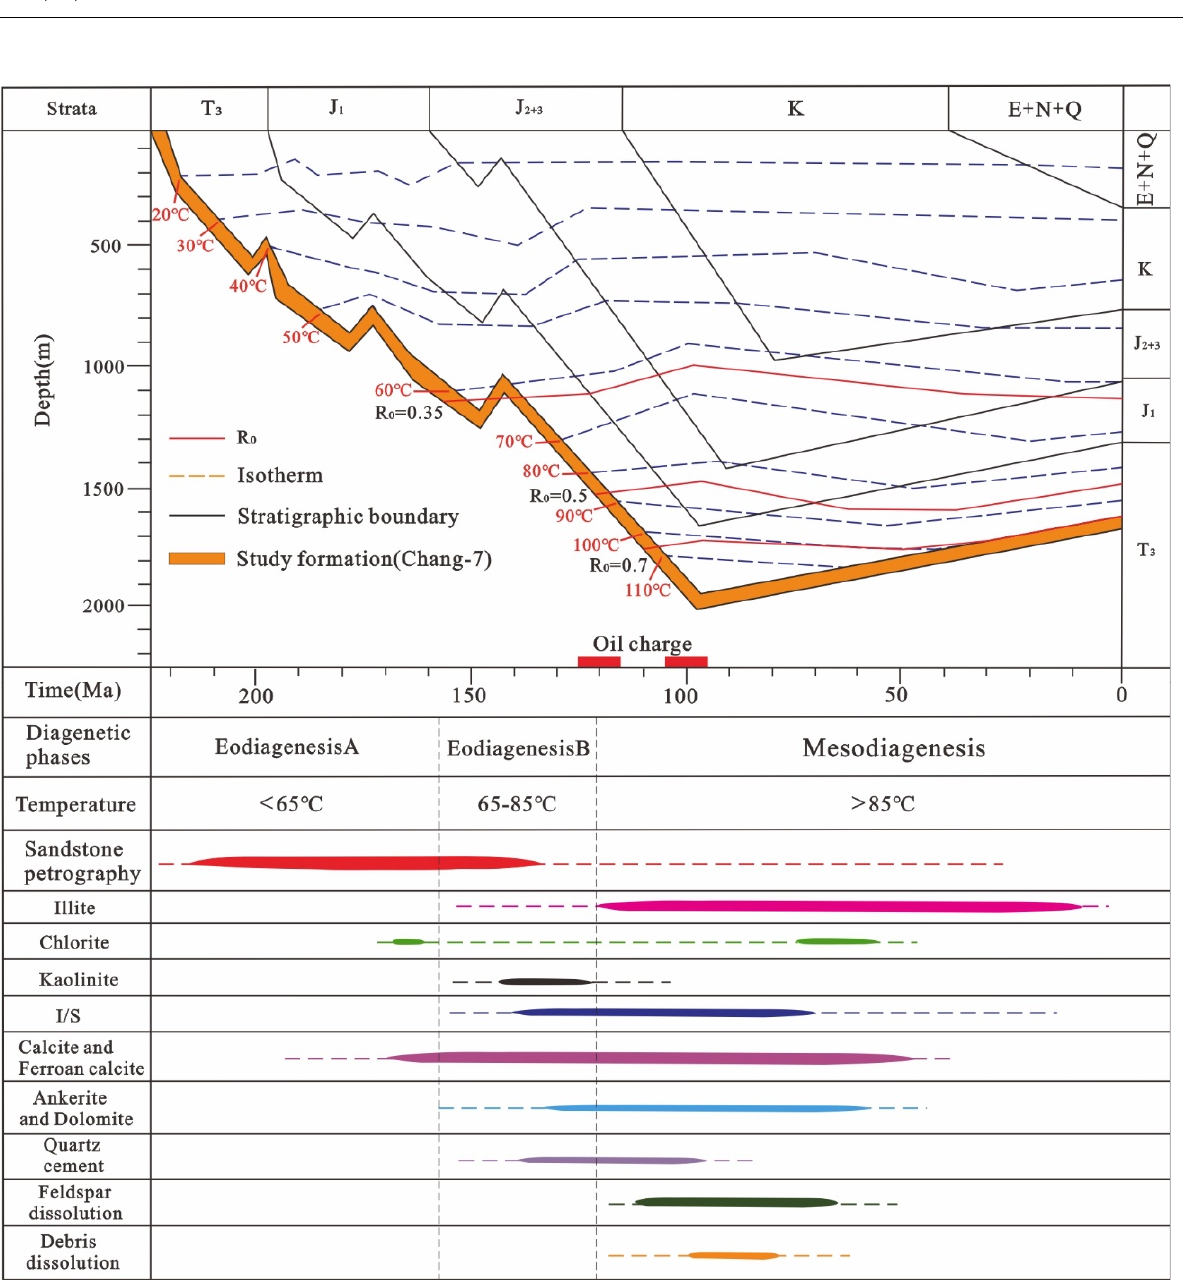
Figure 9. Burial, thermal, and the major diagenetic sequence of the Chang-7 Member in the Ordos Basin [22,25,27].